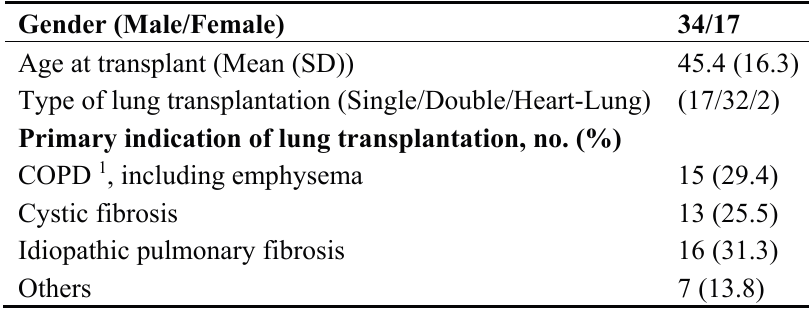
Table 1. Characteristics of the study subjects ( n =